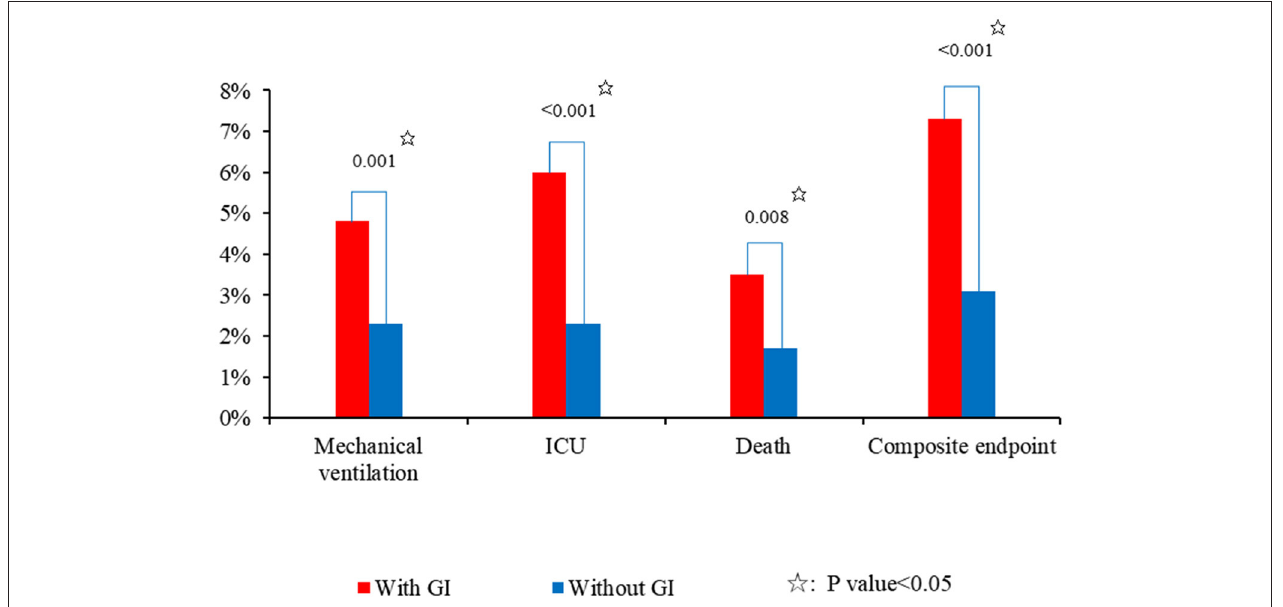
FIGURE 2 | Incidence of adverse outcomes in COVID-19 patients with and without GI